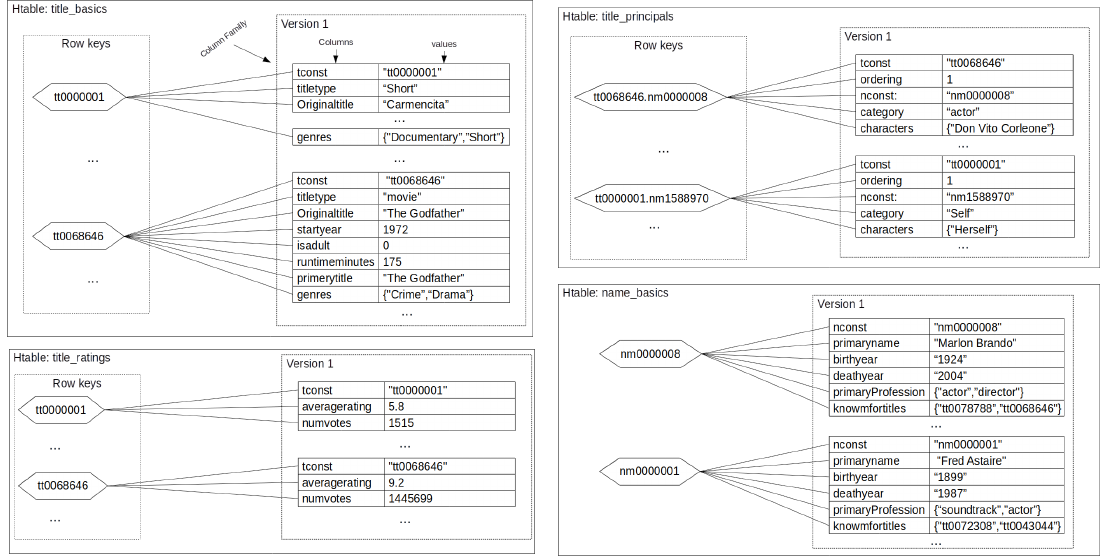
Figure 11. IMDb mapped to HBase according to the DQE